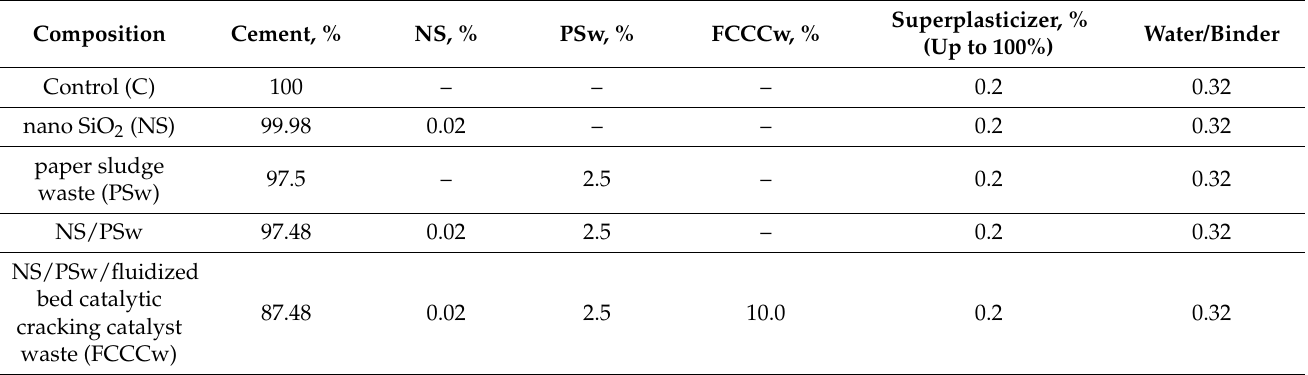
Table 1. Compositions of cement-based